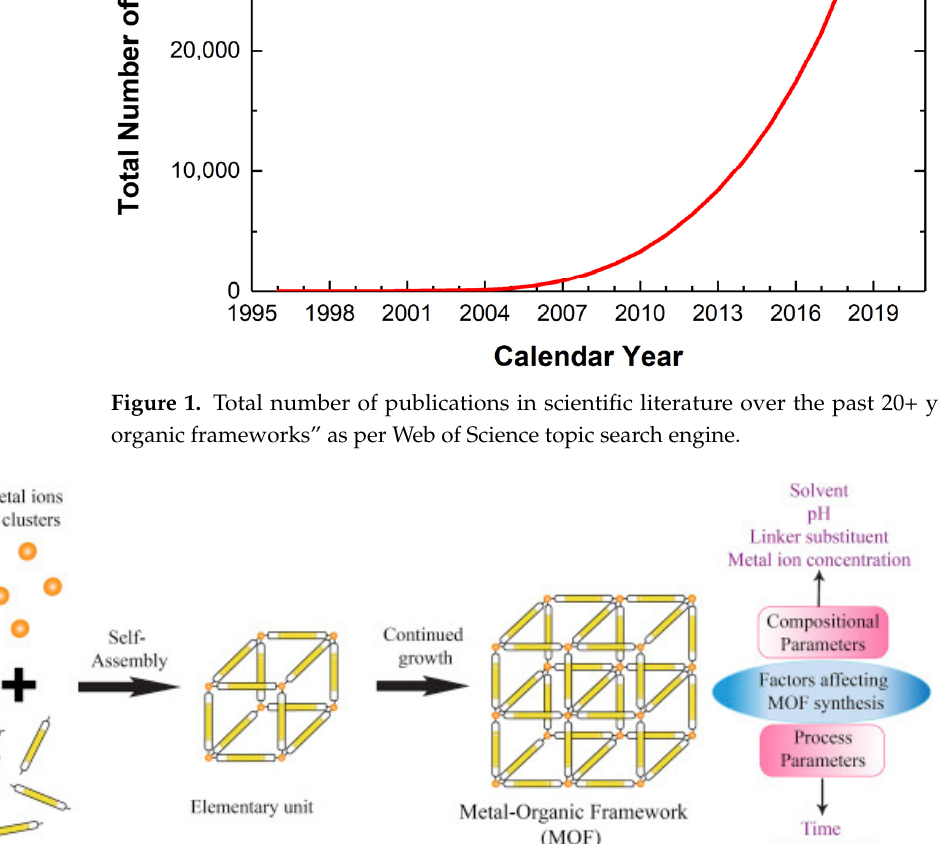
Figure 1. Total number of publications in scientific literature over the past 20+ years for “metal or- ganic frameworks” as per Web of Science topic search engine.